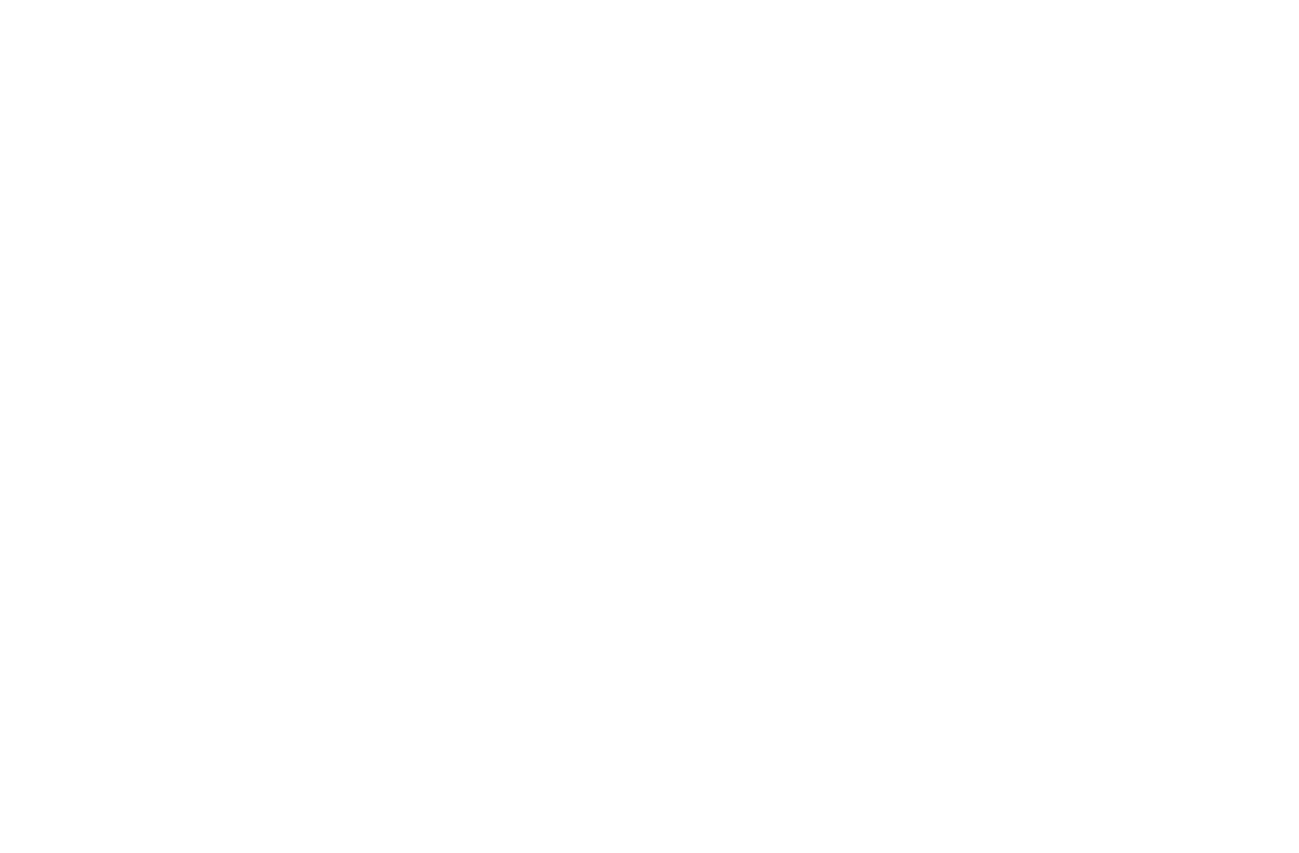
Frontiers in Cellular Neuroscience | www.frontiersin.org